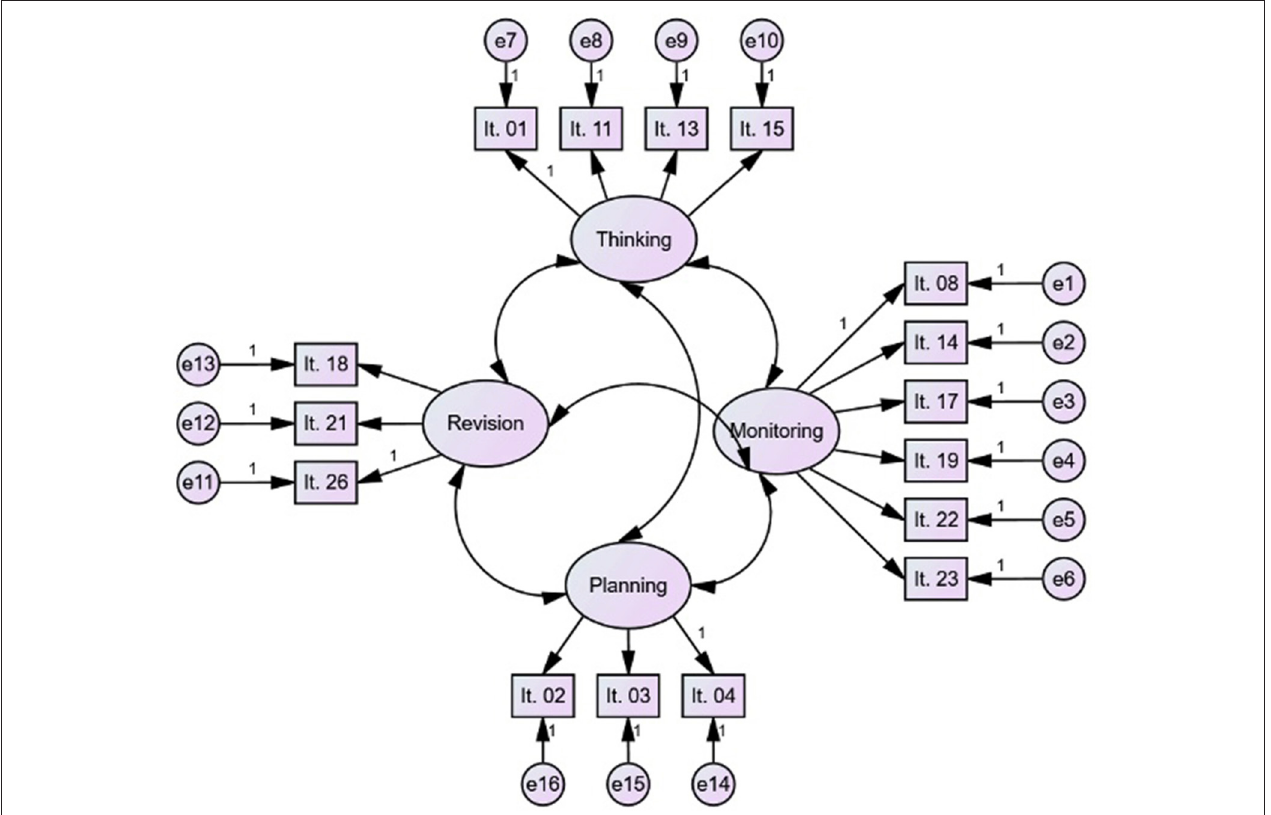
FIGURE 1 | Hypothesized model of the factor structure of the WSQ-SP, composed of four interrelated